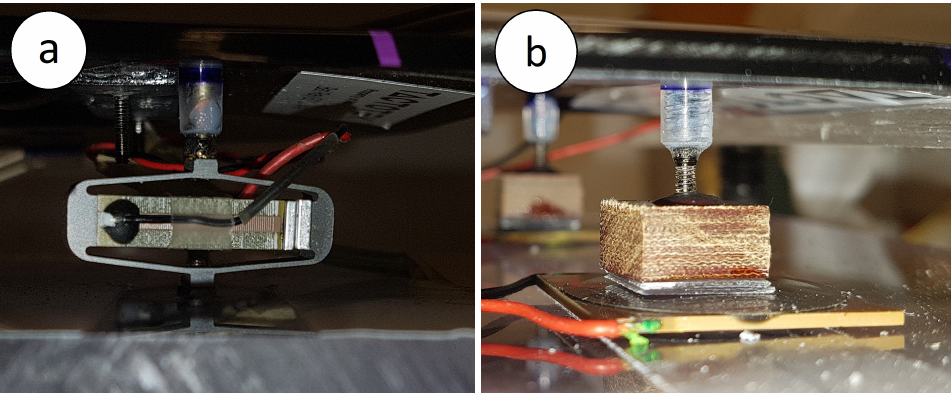
Figure 4. Configuration of Piezo actuators below the control panel. ( a ) The APA120S can be seen to the left, ( b ) while the PowerHap 15G is shown to the